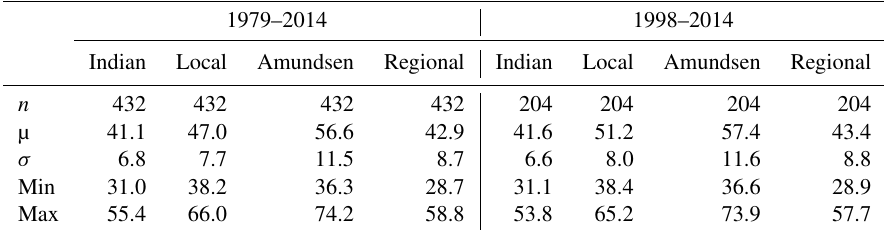
Table 3. Number of points ( n ), time averages (µ), standard deviation ( σ ), minimum (min), and maximum (max) values of monthly meteoro- logical sea ice concentration over the periods 1979–2014 and 1998–2014 extracted from the Nimbus-7 Scanning Multichannel Microwave Radiometer (SMMR) and Defense Meteorological Satellite Program Special Sensor Microwave/Imagers – Special Sensor Microwave Im- age/Sounder (DMSP SSM/I-SSMIS) passive microwave data (http://nsidc.org/data/nsidc-0051, last access: January 2018) (Cavalieri et al., 1996), and for the four regions defined as (i) “local” (135–145 ◦ E), (ii) “Indian” (100–145 ◦ E), (iii) “Amundsen” (160–205 ◦ E), and (iv) “re- gional” (100–205 ◦